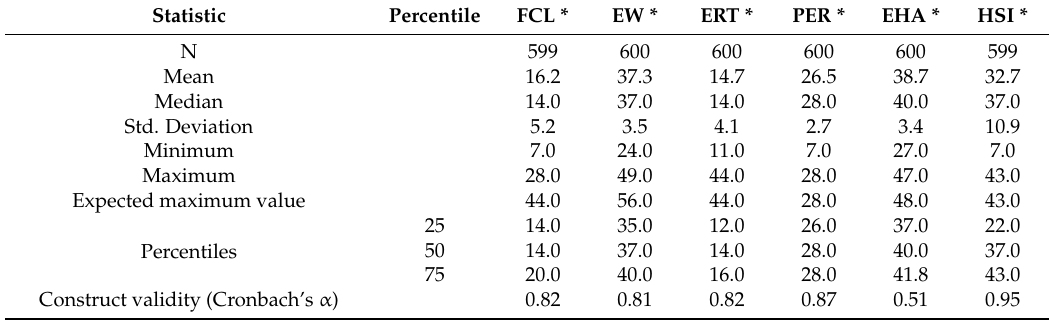
Table 2. Estimated values of the explanatory factor scores and the construct validity of each